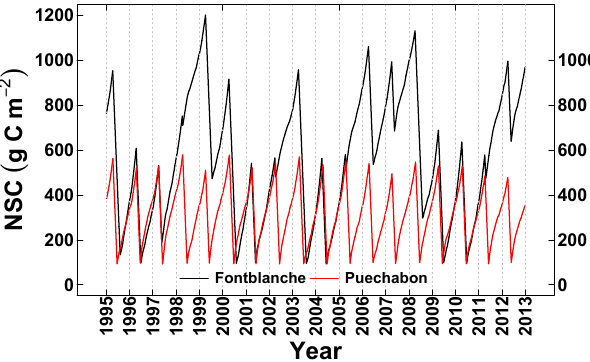
Figure A5. Simulated non-structural carbohydrate content (NSC) in the storage pool at both sites. The period 1995–2012 is shown to highlight within-year